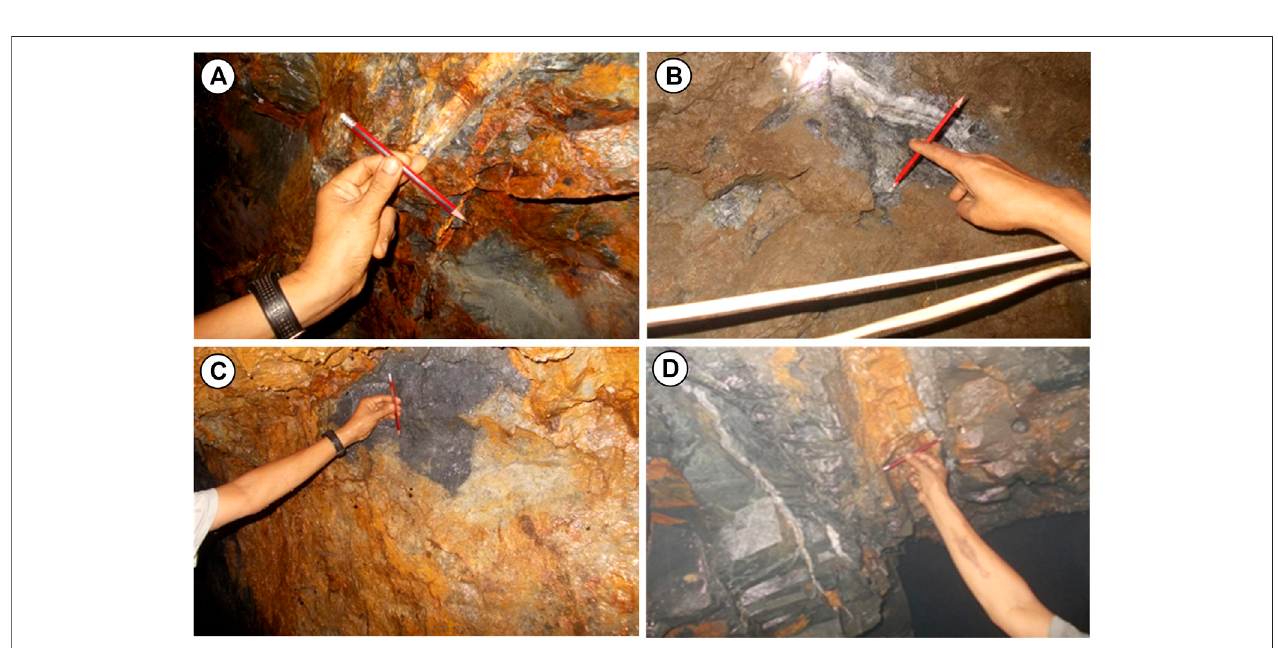
FIGURE 6 | Vein style and texture of the Shwetagun gold deposit. (A) Photographs showing auriferous sheeted quartz vein about 10 cm thickness at adit I, (B) auriferous sheeted quartz vein about 20 cm thickness at adit I, (C) distorted vein by the effects ofshear force at adit II and (D) nature ofauriferous sheeted quartz vein